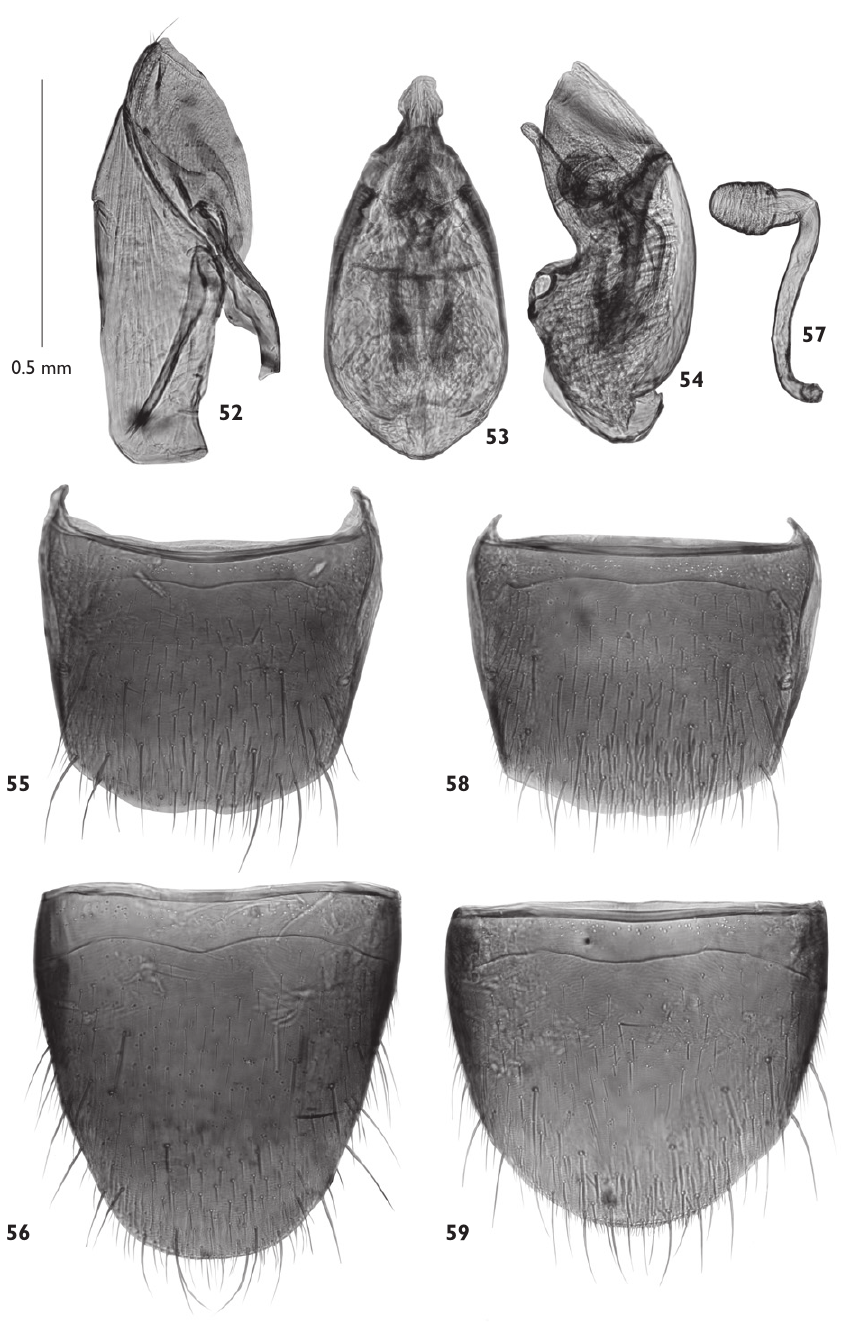
Figures 52–59. Schistoglossa sphagnorum : 52 paramere 53 median lobe of aedeagus in dorsal view 54 median lobe of aedeagus in lateral view 55 male tergite 8 56 male sternite 8 57 spermatheca 58 female tergite 8 59 female sternite